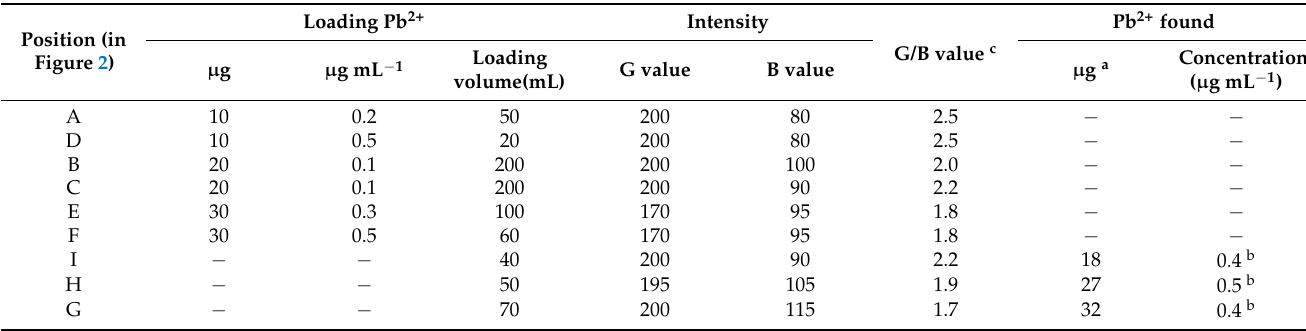
Table 1. Assay using the proposed procedure for one-shot image of a sample with triplicate results via a single standard calibration approach.